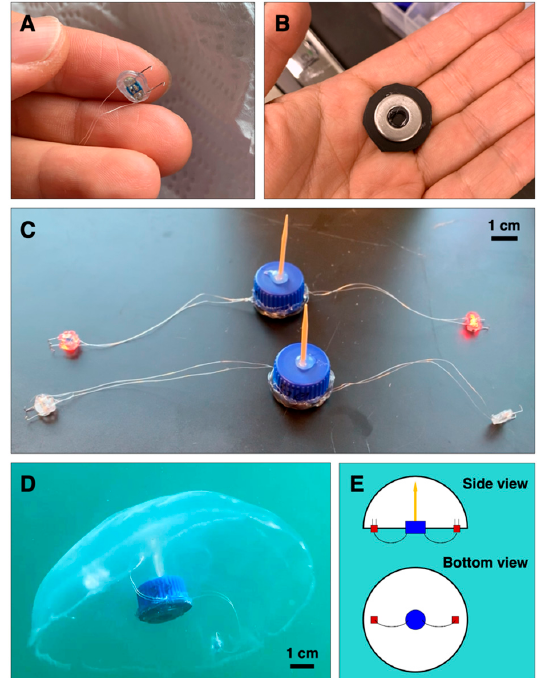
Figure 1. Robotic system using microelectronics. The biohybrid robotic system, adapted from [32], with two new features: ( A ) hooked electrode wire tips instead of straight tips in the previous design, and ( B ) a weighted polypropylene cap to change the ballast and improve the robustness of the system under field conditions, as opposed to no flow in laboratory tank experiments. ( C ) Two of the fully integrated robotic systems with new modifications are shown. The electrodes shown in the back are active (red LEDs, or light-emitting diodes, are on). ( D ) Representative biohybrid robotic jellyfish, comprising the live animal and microelectronic system with two electrodes. ( E ) Side and bottom view schematics of the biohybrid robotic jellyfish. The animal is illustrated in white, swim controller housing in blue, electrodes in red, and wooden pin in yellow.